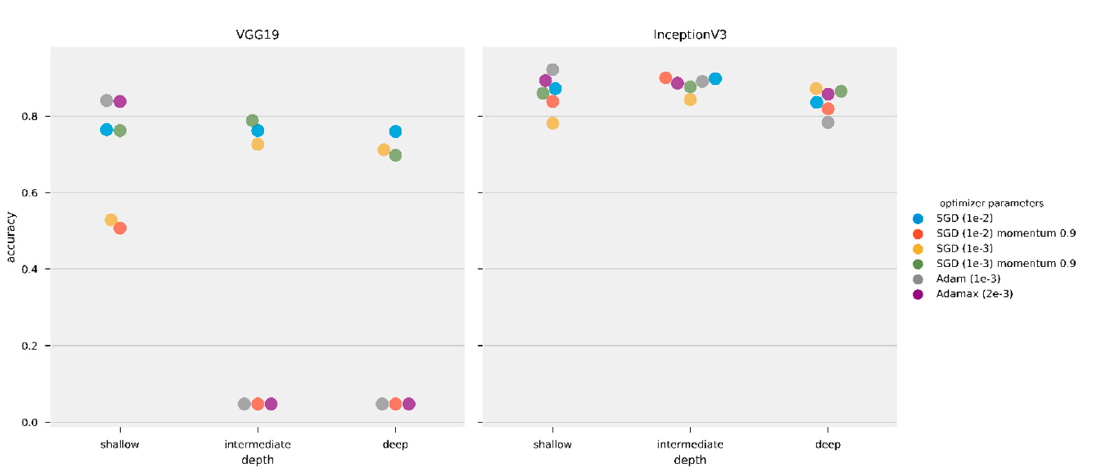
Figure 4. Test set accuracy obtained by the models using different optimizers training on the same UCMerced dataset. The left panel shows VGG 19 results, right panel shows Inception V3 results.